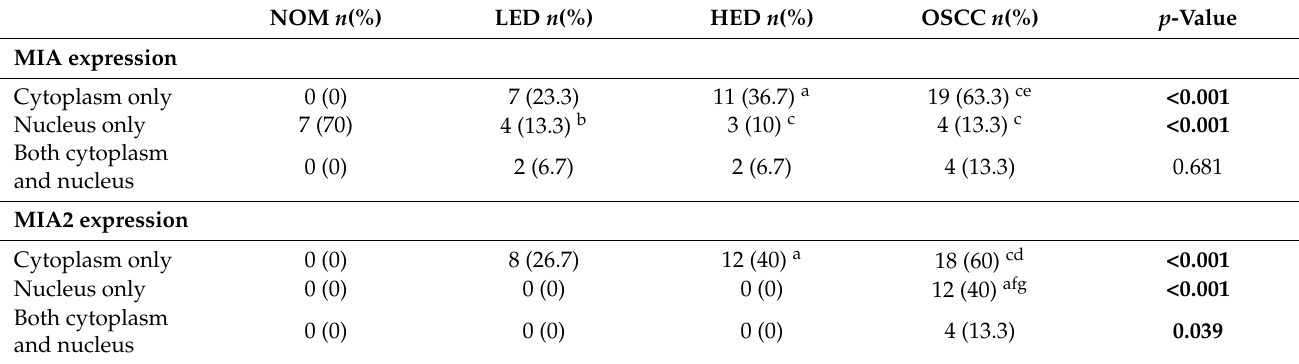
Table 2. Summary of MIA and MIA2 immunolocalization in NOM, OED, and OSCC